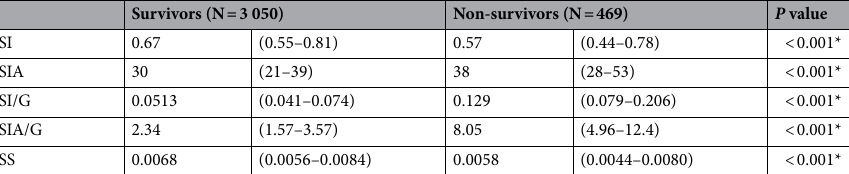
Table 2. Comparison of different shock index variations between 30-day survivors and non-survivors. Data are expressed as median (interquartile range). *Mann–Whitney. SI, shock index; SIA, SI multiplied by age; SI/G, SI divided by Glasgow Coma Score; SIA/G, SI multiplied by age and divided by Glasgow Coma Score; SS, SI divided by oxygen